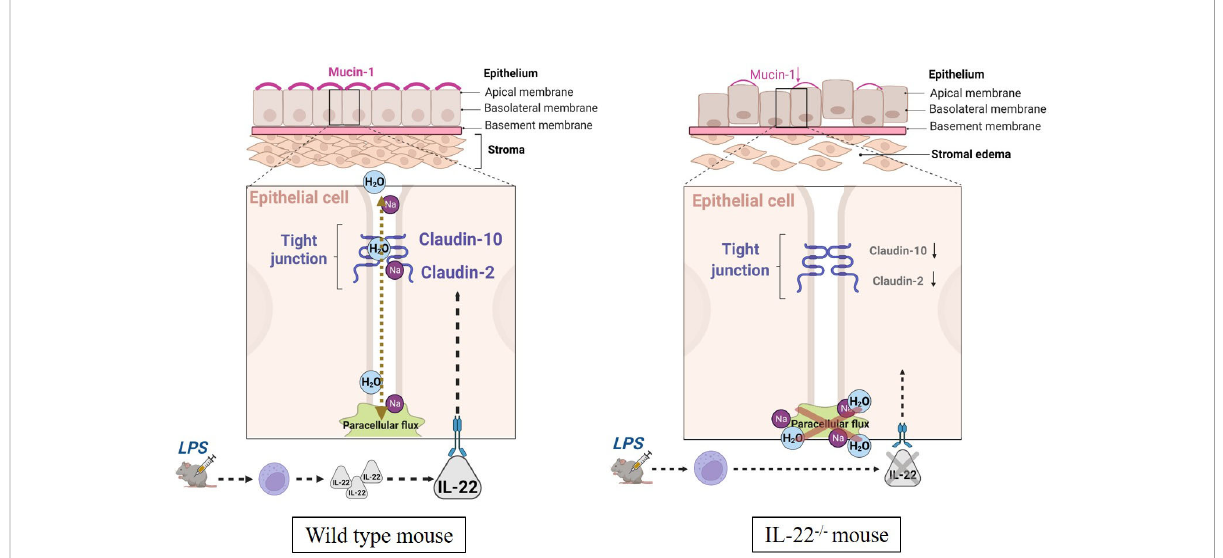
FIGURE 8 The schematic presentation of the impact of IL-22 on endometrial regeneration. In comparison to WT animals, IL-22 − / − mice have lower expression of tight junctions and mucin-1. Decreased amount of tight junctions leads to permeability reduction. Cellular density of stromal compartment in IL-22 − / − mice is lower than in WT mice. This might be explained by disrupted permeability of tight junctions, which fail to adequately facilitate paracellular fl ux (shown in green dotted double-headed arrow in WT mice). This might lead to stromal edema that occurred in IL-22 − / − mice post endotoxin-induced abortion. Hence, IL-22 enhances paracellular fl ux performed by tight junctions (claudin-2 and claudin-10) and upregulates cell surface pathogen protectors (mucin-1) contributing to proper regeneration of endometrial layers after in fl ammation-triggered abortion. IL-22 also participates in the remodeling of the uterine tissue in in fl ammatory environment by regulating other cell – cell contacts called adherens junctions (E- and N-cadherin; not shown on the scheme). Therefore, IL-22 can be considered to perform a dual role: enhance uterine regeneration postpartum and barrier/protect against secondary infertility caused by in fl ammation. LPS, lipopolysaccharide; WT, wild type; IL-22 − / − , IL-22 knockout; Na, sodium; H 2 O,